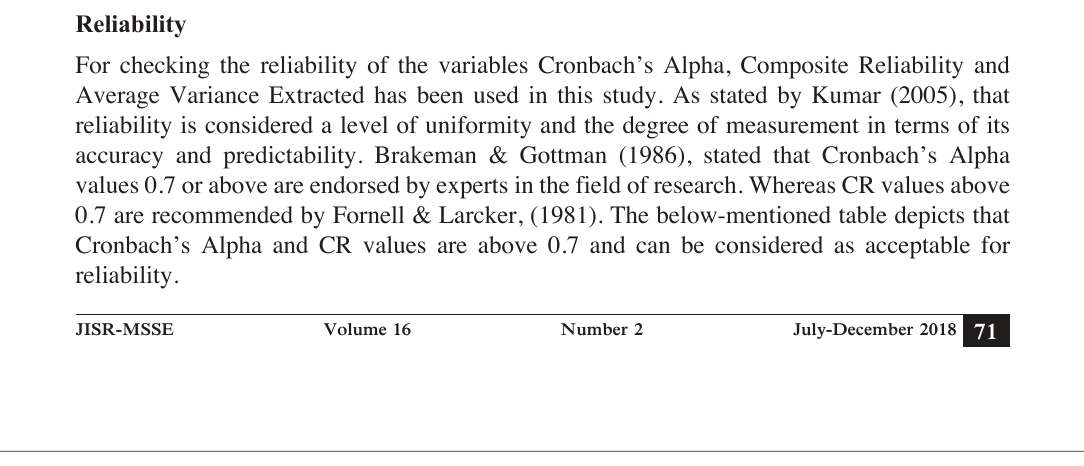
model figure A. Sekaran (2002), recommends that the foremost procedure of information selection is the survey that is the most prevailing process if the expert exactly recognizes what is necessary and how to evaluate the aspects of concern. Entire items of the questionnaire used are evaluated on the 5-point rating scale (Likert scale) for the variables included in the